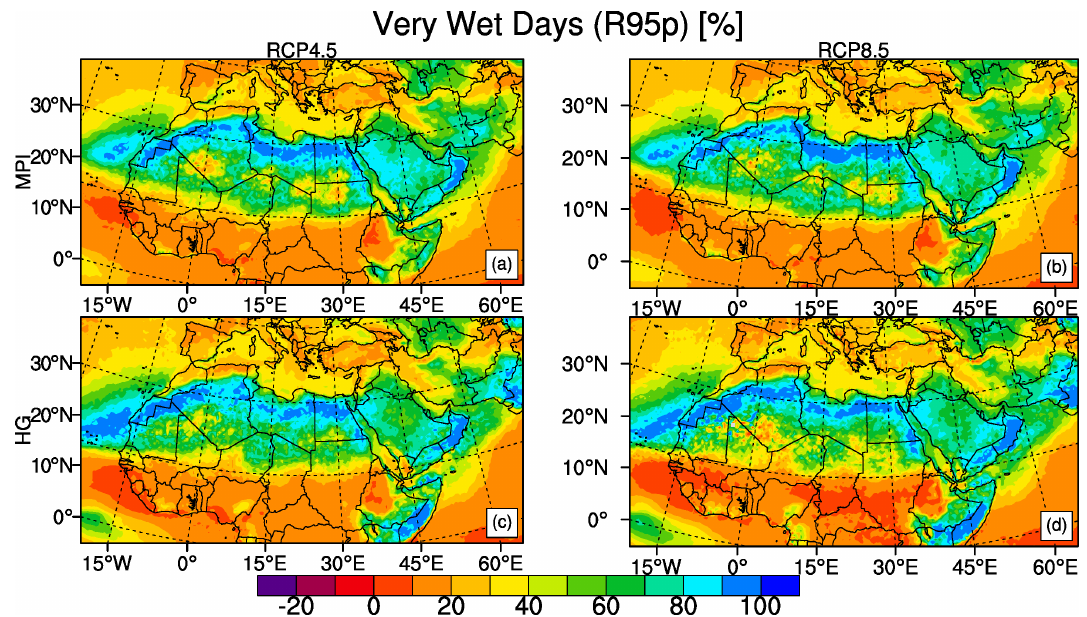
Figure 11. The temporally averaged changes in R95p for the period of 2071–2100 displayed as differences (in %) with respect to the reference period 1971–2000 for the model MPI-ESM-MR with RCP4.5 ( a ) and RCP8.5 ( b ) and for the model